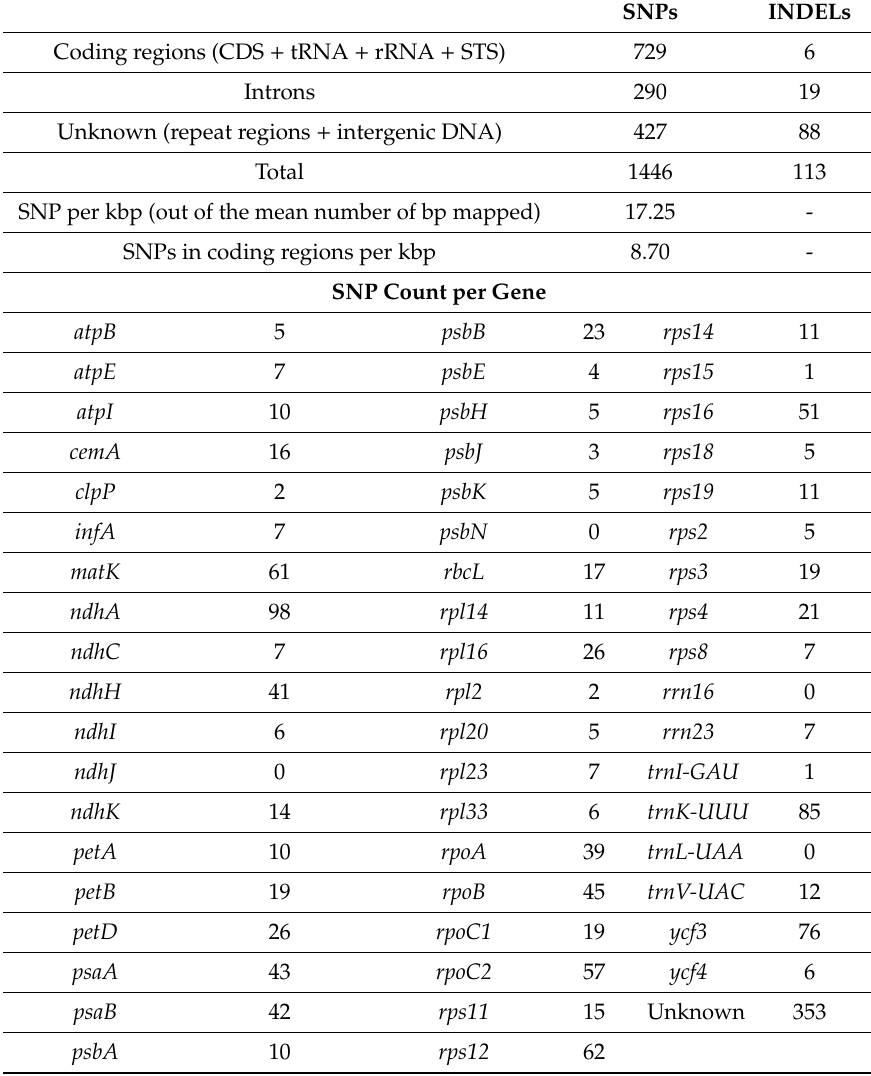
Figure 5. Structure of Dactylis glomerata genotypes estimated using structure analysis of plastome SNPs. Each plant is shown as a vertical bar and SNP variation is partitioned into coloured segments that show the individual’s estimated membership fractions in each of the K = 8 clusters, determined as optimal by the ∆ K statistic [63]. Samples are arranged according to geographic location (1 = Poland, 2 = Germany, 3 = Denmark, 4 = Sweden, 5 = Ireland, 6 = UK). Alternative values of K were tested but did not clarify groups any more than the optimal value of eight. An alternative plot with K = 5 is shown in Figure S5 as an example. Table 3. Plastome variation in Dactylis glomerata